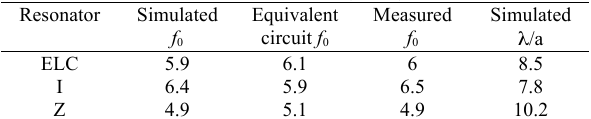
Table 1: Computed and measured resonance frequencies of the resonators